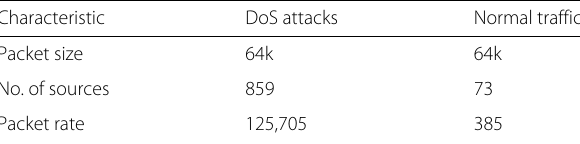
Table 5 Attack and normal traffic features extracted from CAIDA and FIFA World Cup’